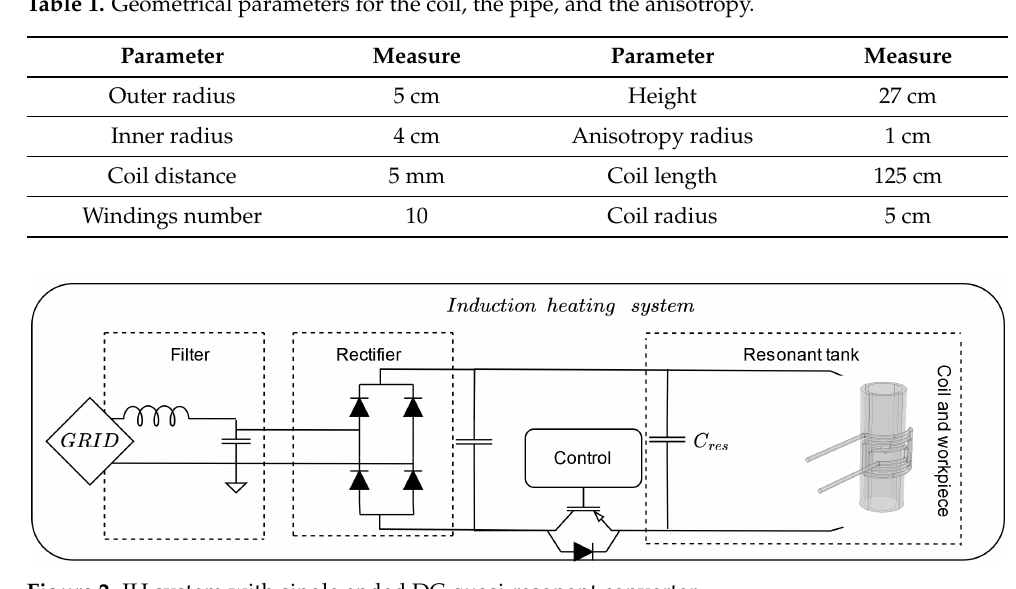
Figure 2. IH system with single ended DC quasi-resonant